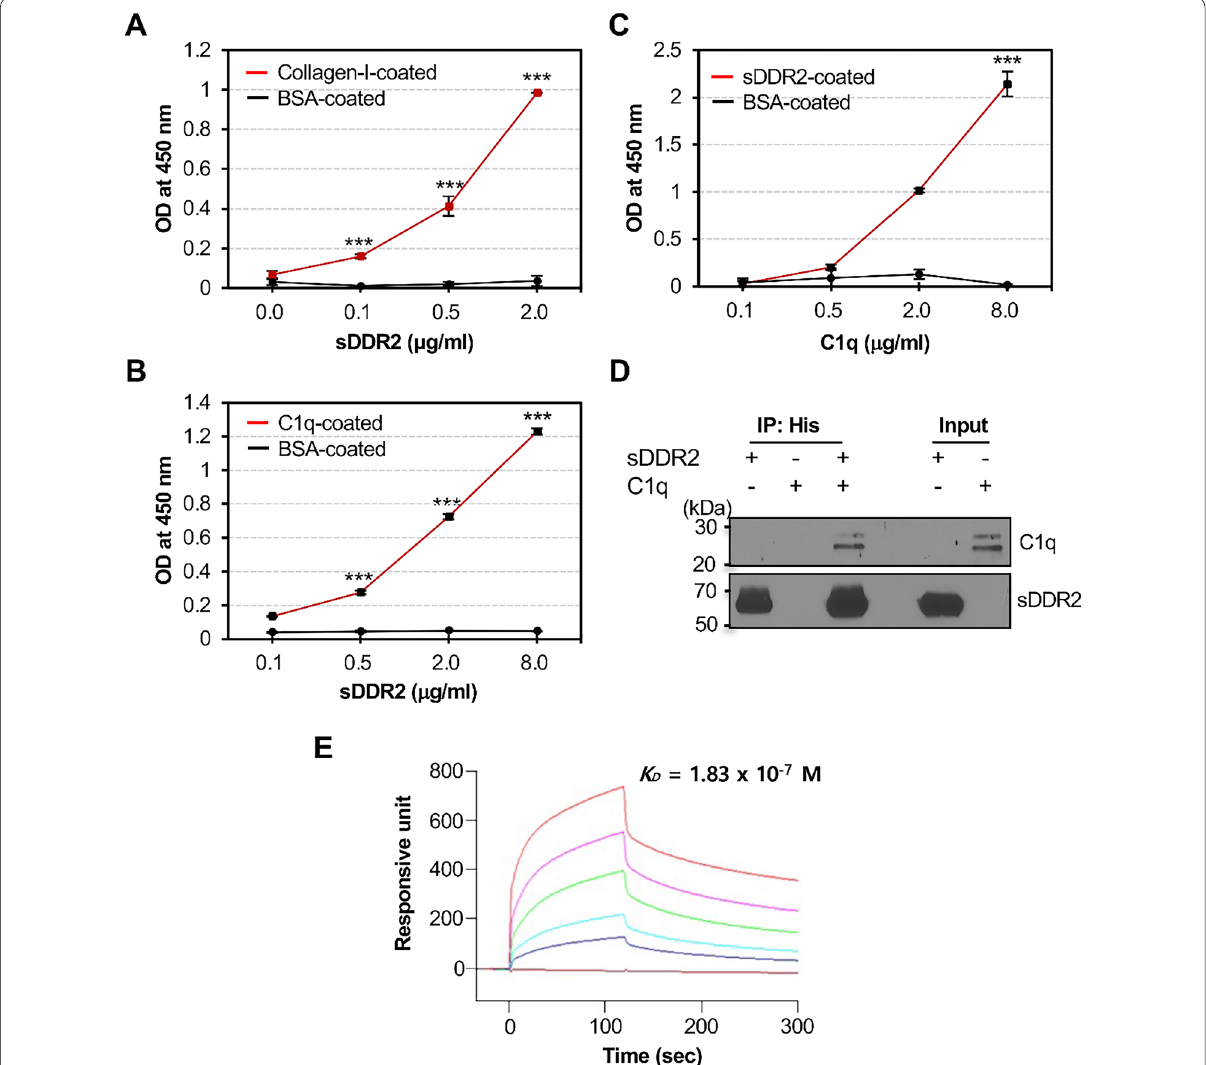
Fig. 1 C1q binds to DDR2. A , B Microtiter plates were immobilized with 2 μg/mL collagen‑I ( A ) and 8 μg/mL C1q ( B ). Respective concentrations of BSA were also coated as a negative control protein. Various concentrations of sDDR2 were added to the wells and ELISA was conducted to observe the binding. Blank well values were subtracted for analysis. C Microtiter plates were immobilized with 2 μg/mL each of sDDR2 and BSA, and various concentrations of C1q (0.1, 0.5, 2, and 8 μg/mL) were added to evaluate the binding of DDR2 with C1q. The graph shows the mean independent experiments. *** p < 0.001 (one‑way ANOVA). D Pull‑down assay of 100 ng sDDR2 and 100 ng C1q were tested with Sepharose‑based complete His‑tag purification resin. Antibodies for western blot analyses are as indicated. E Surface plasmon analysis of C1q binding to DDR2. Various concentrations of C1q protein (0, 2.5, 5, 10, 20, and 40 μg/mL) were applied on an sDDR2‑immobilized sensor chip